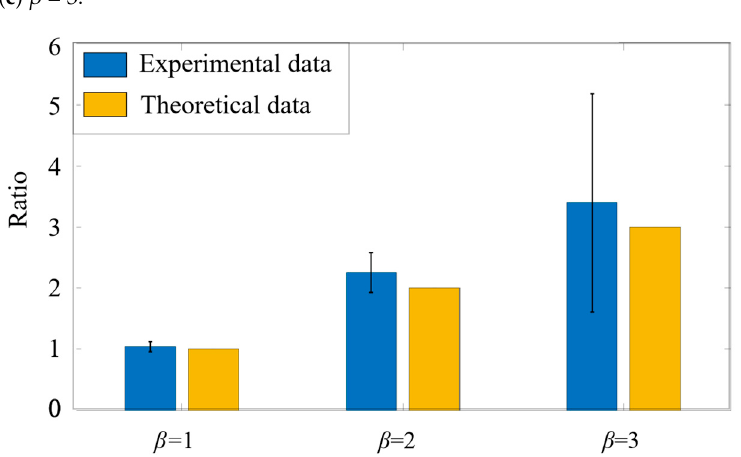
Figure 13. Comparison between the experimental ratios and the theoretical ones in the mixed solutions. The blue histogram represents the experimental measurement results, and the yellow histogram is used as a theoretical value comparison.